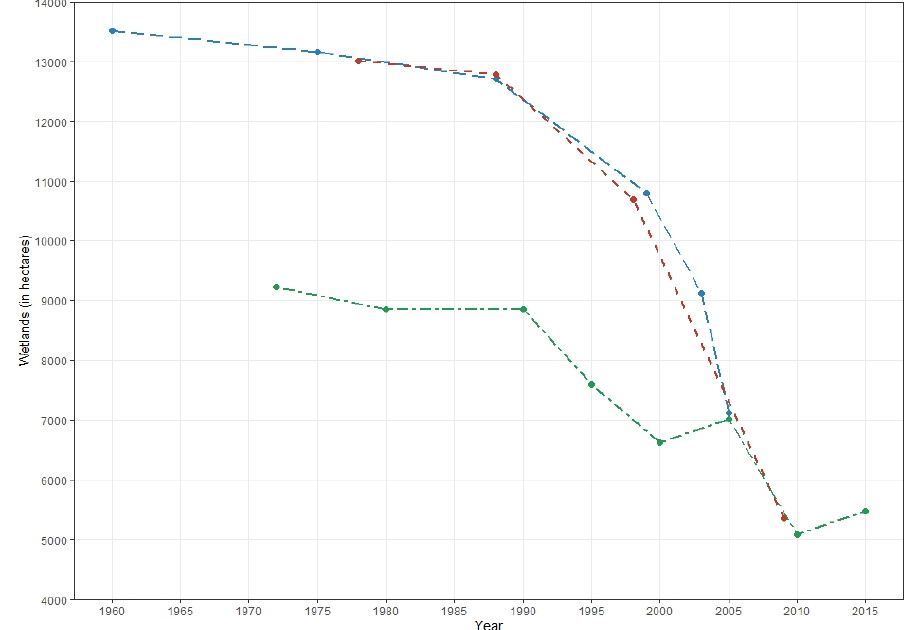
Figure 7. Trend of wetlands change in Dhaka metropolitan area and its surroundings as reported by [39] ( blue line ), [41] ( red line ), and [42] ( green line ).